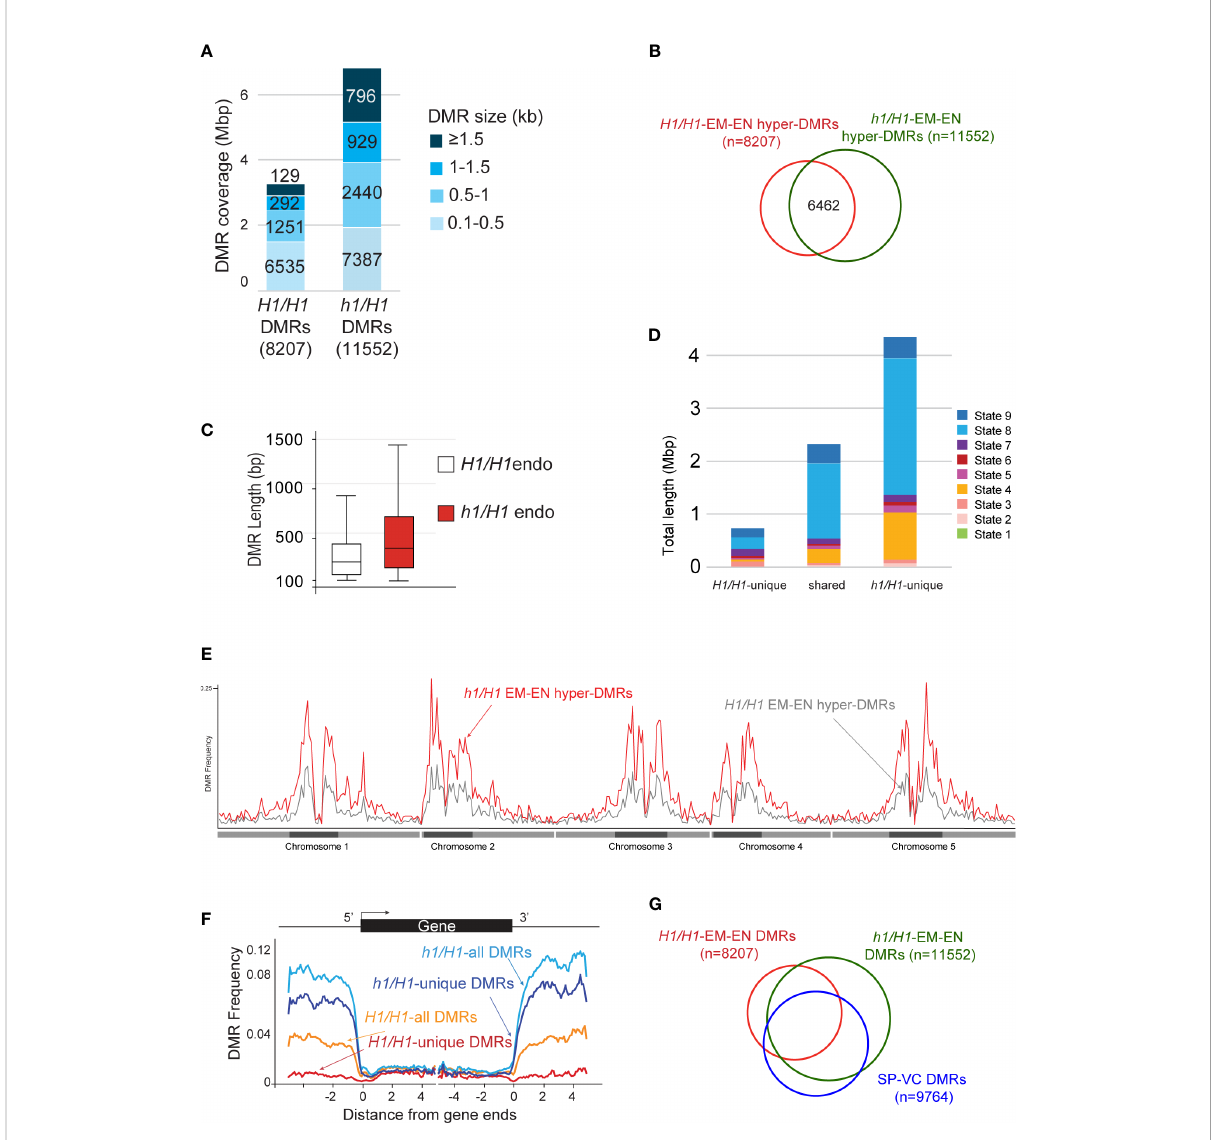
FIGURE 4 Analysis of the hyper DMRs of embryo vs endosperm derived from maternal wild type or h1 mutant crossed with L er pollen. (A) Wild-type H1/H1 and mutant h1/H1 DMRs grouped by size, with the cumulative total length they cover shown. (B) Venn diagram depicting overlaps between H1/ H1 and h1/H1 DMRs. (C) Boxplot showing the length distribution of H1/H1 and h1/H1 DMRs. (D) Chromatin state distribution, and the total length they covered, within H1/H1 -unique, shared, and h1/H1 -unique DMRs. States 1 to 7 correspond to euchromatin, and states 8 and 9 correspond to AT- and GC-rich heterochromatin, respectively. (E) Distribution frequency of DMRs along the 5 chromosomes. Dark blocks represent centromere and peri-centromeric regions of each chromosome. (F) Distribution frequency of DMRs with respect to coding genes. Genes were aligned at the 5 ’ - or the 3 ’ -end, and the proportion of genes with DMRs in each 100-bp interval is plotted. DMR distribution is shown with respect to all H1/H1 -DMRs (orange trace), H1/H1 -unique DMRs (red trace), all h1/H1 -DMRs (light blue trace), and h1/H1 -unique DMRs (dark blue trace). (G) Venn diagram showing overlaps between H1/H1, h1/H1 , and sperm vs vegetative cell